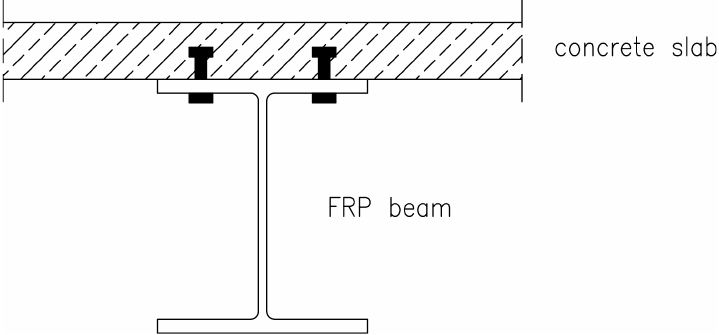
Figure 11. Hybrid girder, FRP–concrete. The use of a massive concrete slab effectively increases the stiffness of the entire girder, allowing for the effective use of the properties of individual components. In a girder subjected to bending, the compressive stresses are transferred by concrete, while the tensile stresses occur in the composite element. The use of concrete also allows the cost of the entire structure to be reduced. Hybrid solutions have been in use for about 20 years [8]. Their excellent strength-to-weight ratio, unattainable for traditional building materials [55], predestines composites for use in portable bridges, especially in the case of temporary military bridges, where low weight and ease of transport, combined with high strength, are features of particular importance. Therefore, FRP composites are used to make both pontoon bridges (Figure 12), as well as trusses, beams and other structures. The first objects of this type were built at the turn of the 20th and 21st centuries in the United